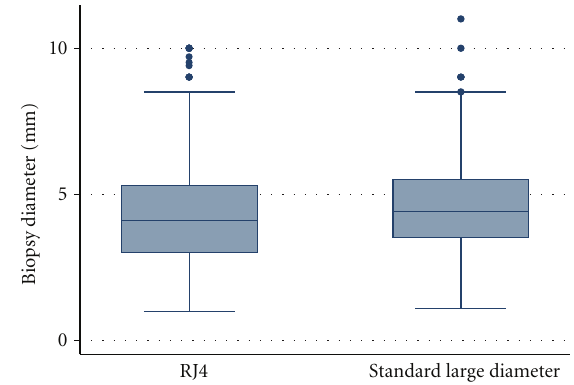
Figure 2: Comparison of mean biopsy diameter for specimens taken with the RJ4 forceps and standard large diameter